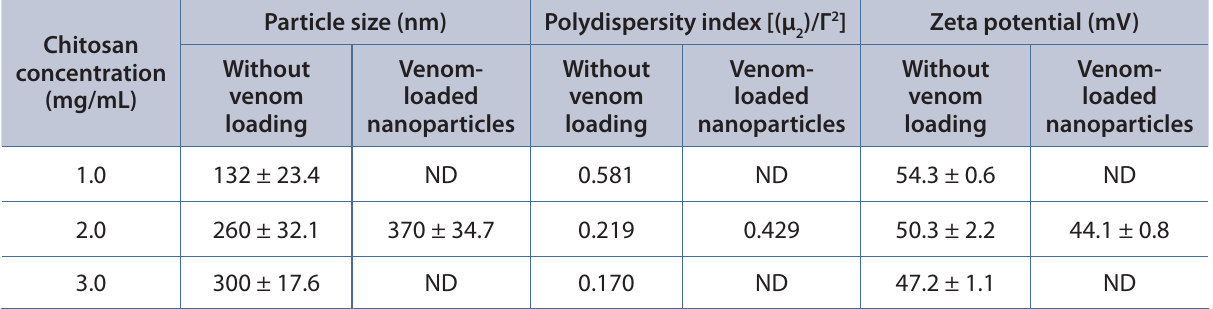
Table 1. Particle size, polydispersity index and zeta potential of low molecular weight chitosan nanoparticles and venom-loaded chitosan